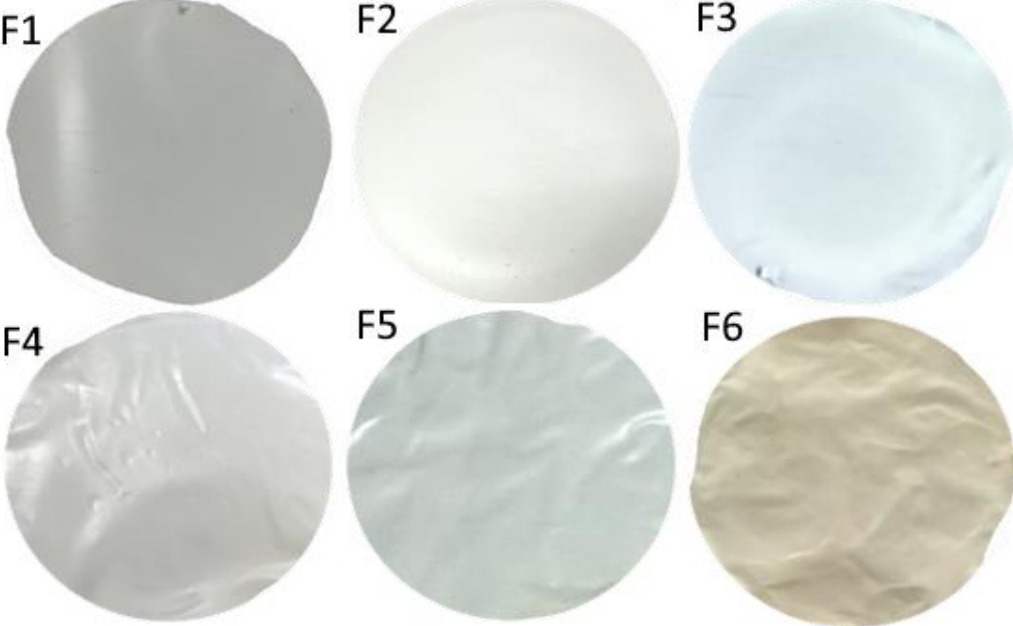
Figure 1. The visual appearance of the biocomposite films incorporated with CMC and TM concen- trations with ZnO nanoparticles, BCS oil, and glycerol. CMC, carboxymethyl cellulose; TM, taro mucilage; ZnO, Zinc oxide; BCS: black cumin seed. For sample codes F1 to F6, refer to Table 1.